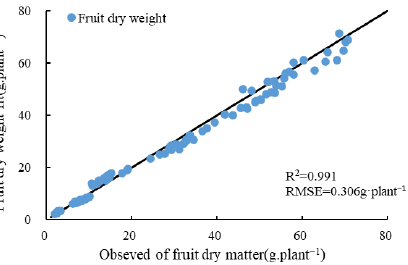
Figure 12. Comparison of observed and simulated values of fruit dry weight fit under LT and PL stresses. Note: The line represents the situation when the observed and simulated values coincide exactly. Comparing the simulated values with the line provides a better view of the simulation.